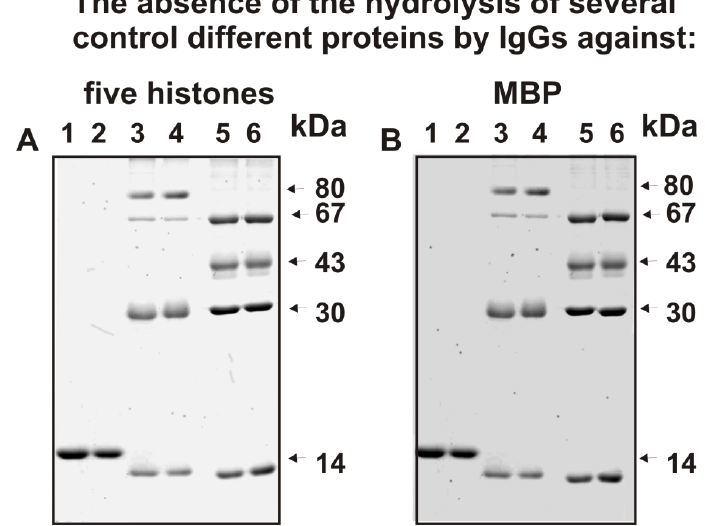
Figure 3. SDS-PAGE analysis of hydrolysis by IgGs of different control proteins ( A , B ); odd and even numbers of line pairs correspond to various proteins incubated with and without IgG preparation, respectively: 1 and 2–egg lysozyme (~14 kDa), 3 and 4–mixture of human milk lactoferrin (~80 kDa), human albumin (~67 kDa), human casein (~30 kDa), and human lactalbumin (~14 kDa); 5 and 6–mixture of some protein molecular mass markers –bovine albumin (~67 kDa), egg ovalbumin (~43 kDa), bovine carbonic anhydrase (~30 kDa), and bovine milk α -lactalbumin (~14.4 kDa). All mixtures with and without IgGs (0.03 mg/mL) were incubated for 12 h.